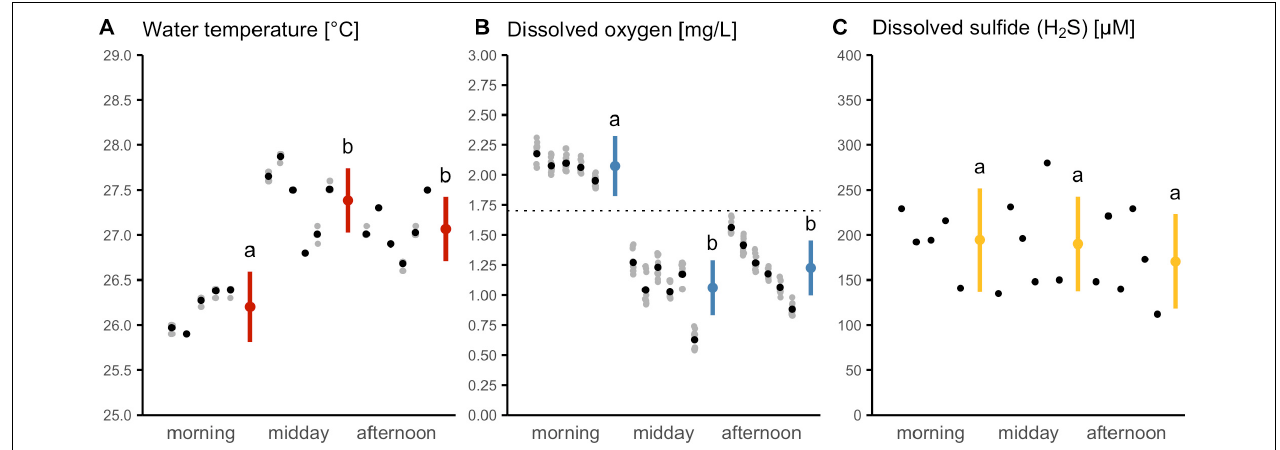
FIGURE 1 | Diurnal variation in water parameters of a sulfidic stream at Baños del Azufre, Mexico. A cross section of the stream was repeatedly sampled during three daytime periods on 6 consecutive days ( n = 17 sampling occasions; morning Day 1 excluded). Shown are multiple measurements (gray), which were sample-pooled for analysis (black). Time of day affected (A) water temperature and (B) dissolved oxygen concentration, but not (C) dissolved sulfide concentration (see model-estimated marginal means with 95% CI in red, blue, yellow). Letters indicate results from post hoc pairwise comparisons. The dashed line indicates a laboratory-established threshold at which Poecilia sulphuraria predominantly performed aquatic surface respiration (ASR 50 ; see results below). TABLE 1 | Descriptive statistics of diurnal variation in abiotic and biotic parameters at the Baños del Azufre sulfur spring complex. Time of